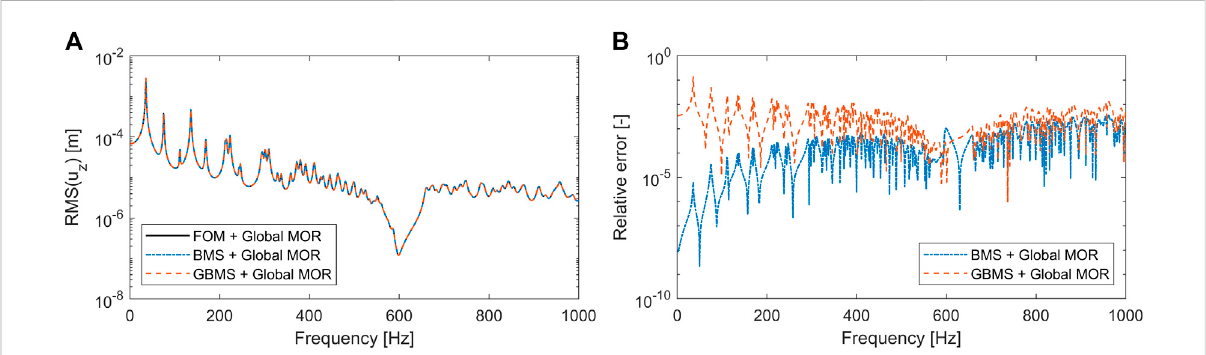
FIGURE 6 Forced vibration frequency responses (A) and relative error with respect to the FOM + global MOR (B) computed for the clamped fi nite plate assembly of 15 × 15 UCs for different ROMs. The good agreement between the results causes the frequency responses (A) to appear on top of each other.